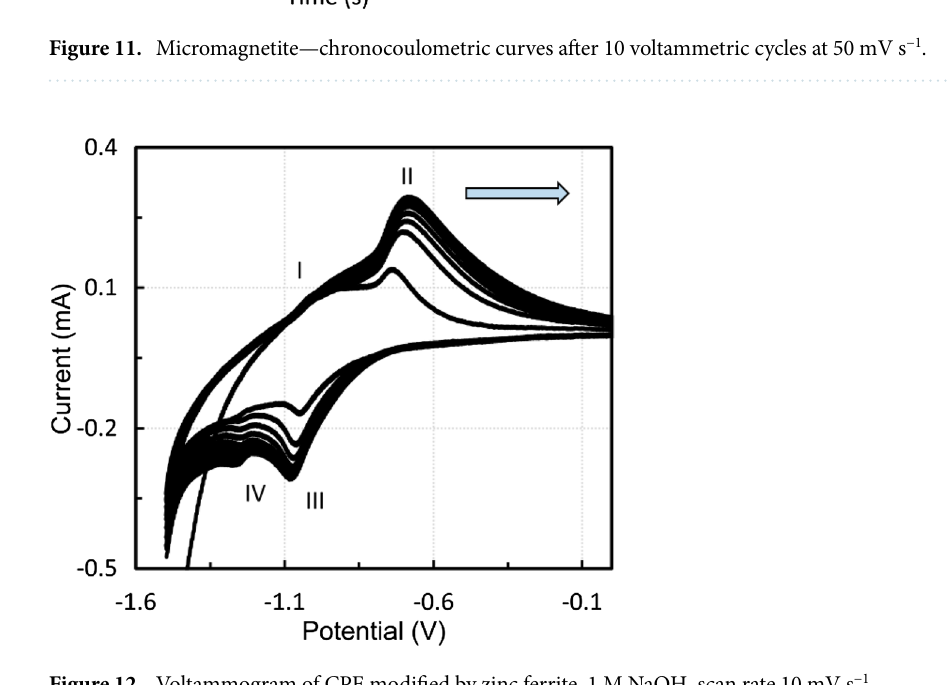
Figure 12. Voltammogram of CPE modified by zinc ferrite, 1 M NaOH, scan rate 10 mV s −1